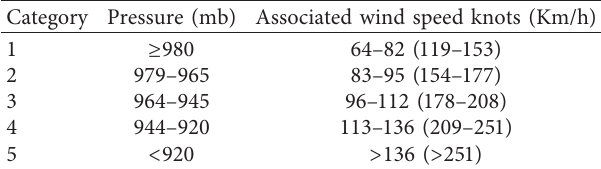
Figure 1: Monthly frequency of TCs in the Arabian Sea during 1891–2019 (source: IMD). Table 1: The classification of TCs in the Saffir Simpson scale according to the central pressure and the wind